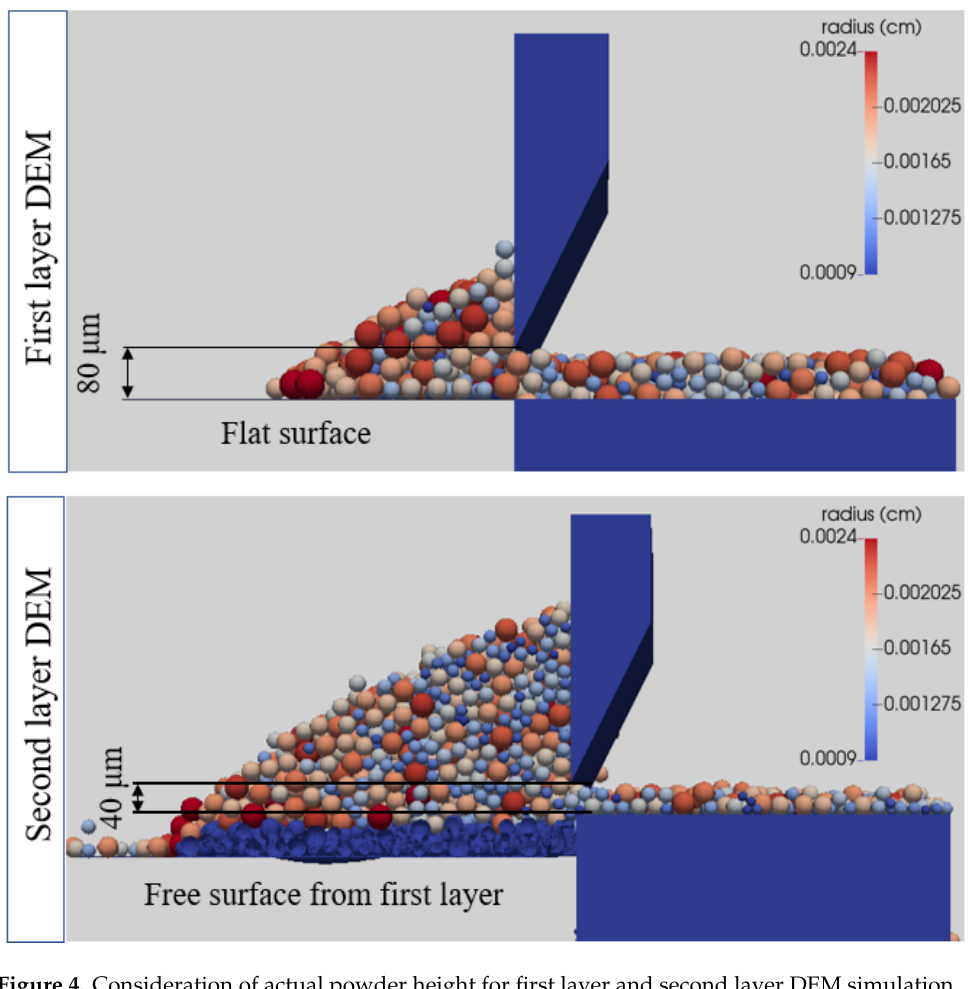
Figure 4. Consideration of actual powder height for first layer and second layer DEM simulation.